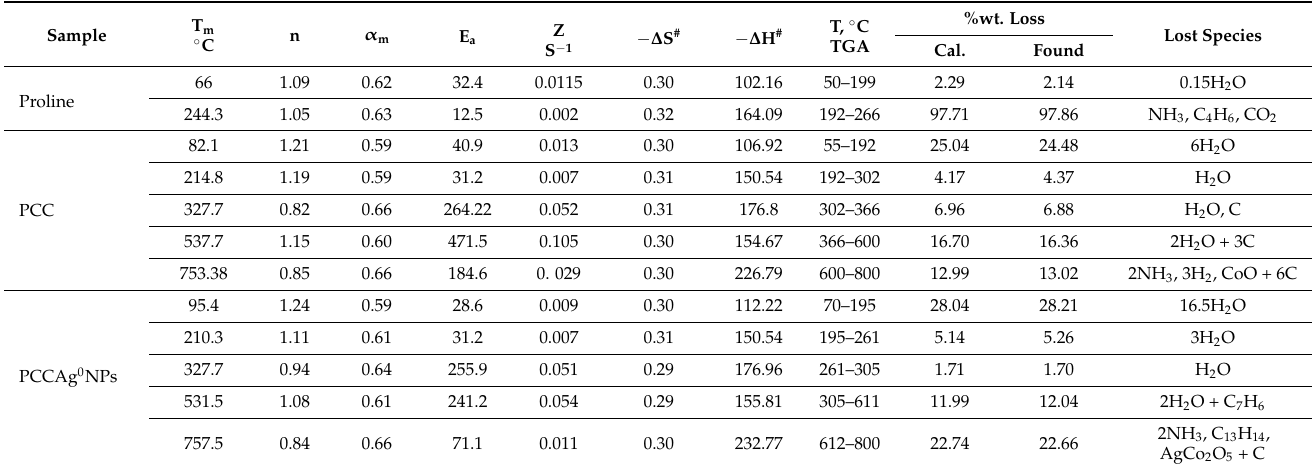
Figure 5. Thermal gravimetric analysis and differential thermal analysis thermograms of PCCAg 0 NPs. Table 4. DTA analysis of proline and